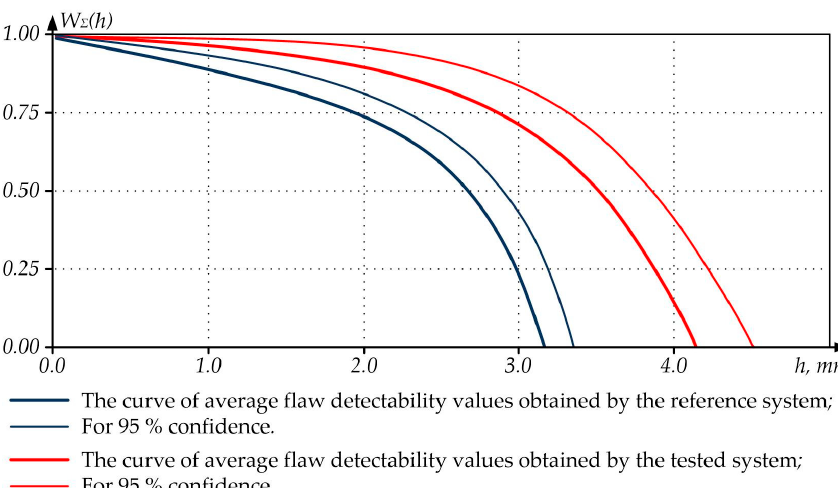
Figure 10. Curves of Flaw Detectability Depending on the Flaw Depth.